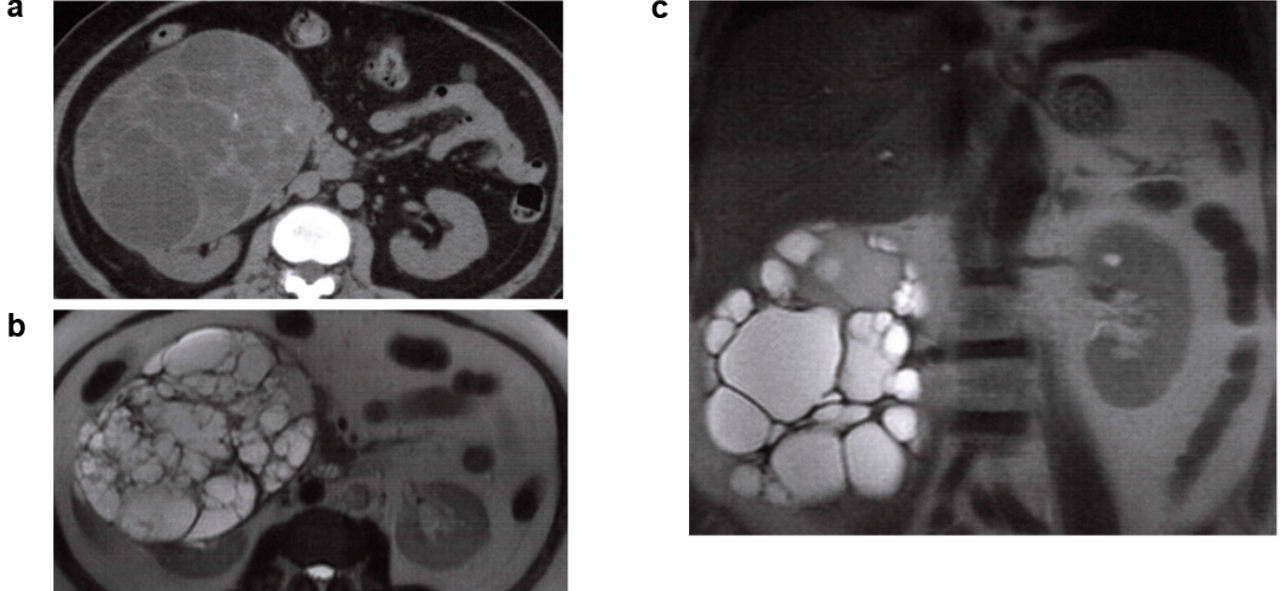
Figure 3. Multilocular renal cyst, multilocular cystic nephroma, polycystic nephroma: 60s, female, no family history of polycystic kidney disease or end-stage kidney disease, no history of hepatic cysts, cerebral aneurysm, or heart valve disease, kidney function eGFR 82.7 mL/min/1.73 m 2 (image provided by Toranomon Hospital). ( a ) Non-contrast CT image (horizontal section): well-defined multilocular mass is visible on the right kidney. ( b ) MRI T2-weighted image (horizontal section): hyperintense polycystic mass (hypointense septum) is visible on the right kidney. ( c ) MRI T2- weighted image (coronal section): hyperintense polycystic mass (hypointense septum) is visible on the right kidney.